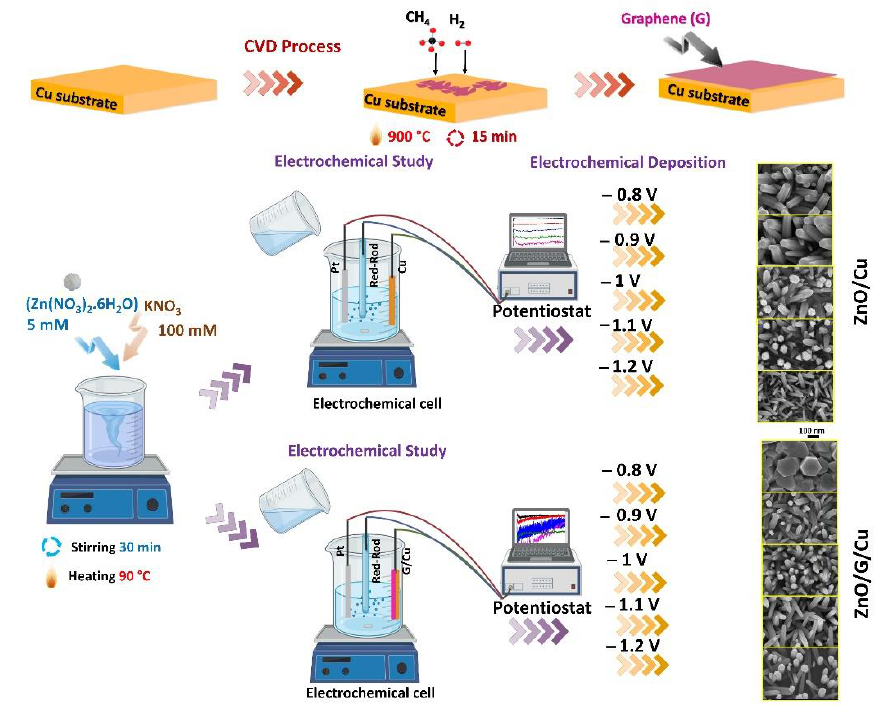
Figure 1. Synthesis process of CVD-graphene, ZnO/Cu, and ZnO/graphene/Cu at different applied potentials.